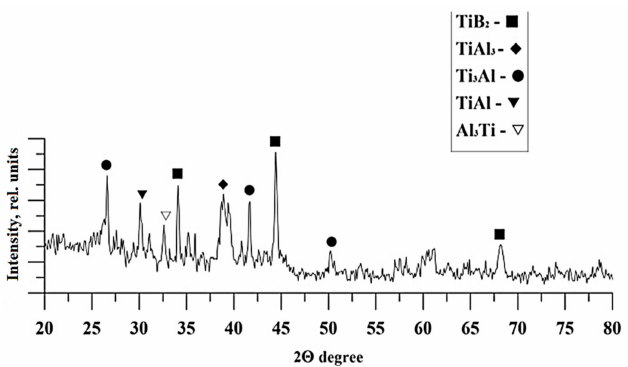
Figure 2. X-ray di ff raction diagram of the